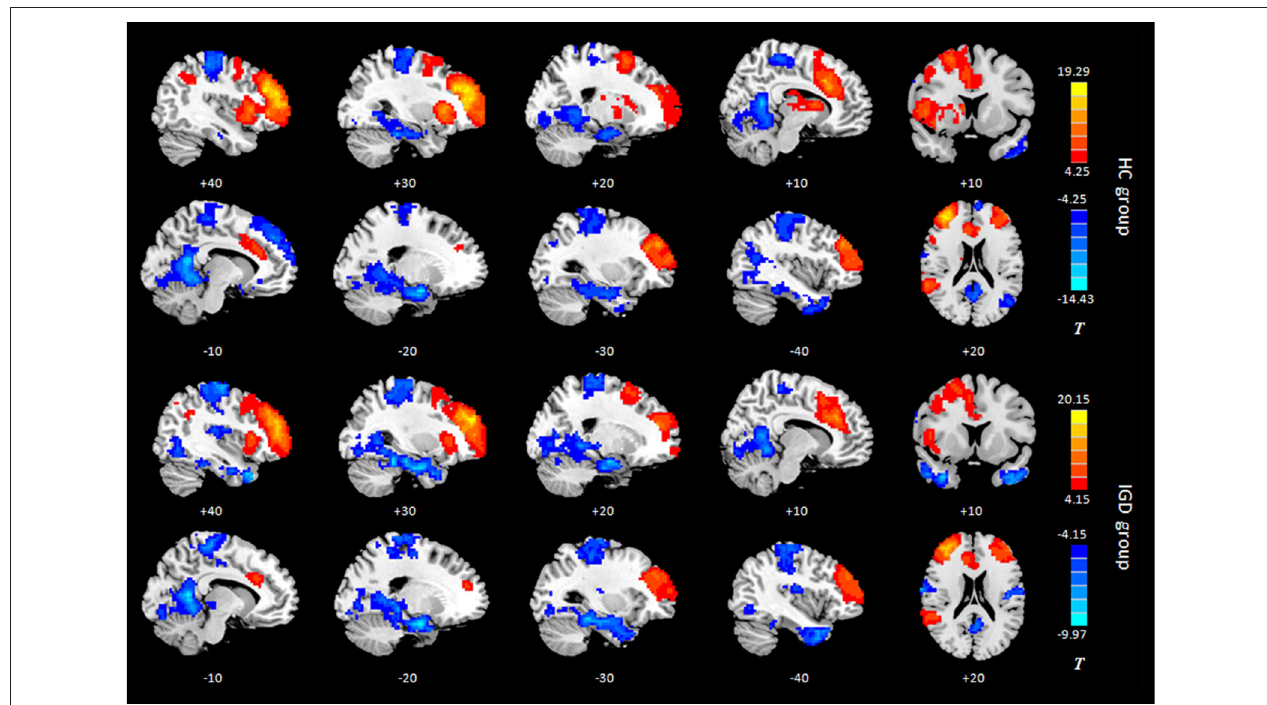
FIGURE 2 | Intragroup maps of connectivity to the right DLPFC of the resting-state networks. Significant connectivity regions are overlaid on the MNI template ( p < 0.001, FDR-corrected). Color bar, yellow (orange): regions showing positive FC, blue: regions showing negative FC. HC, healthy control; IGD, internet gaming disorder. DLPFC, dorsolateral prefrontal cortex; MNI, Montreal Neurological Institute.